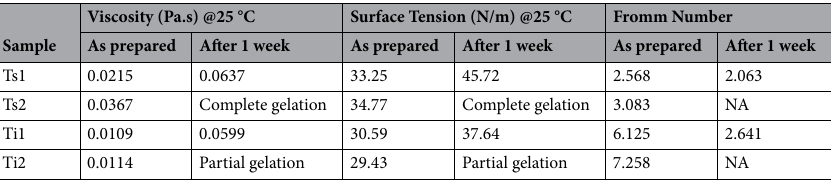
Table 2. Viscosity and surface tension data for the TEOS and TMMS based solutions and inks freshly prepared and after 1 week.